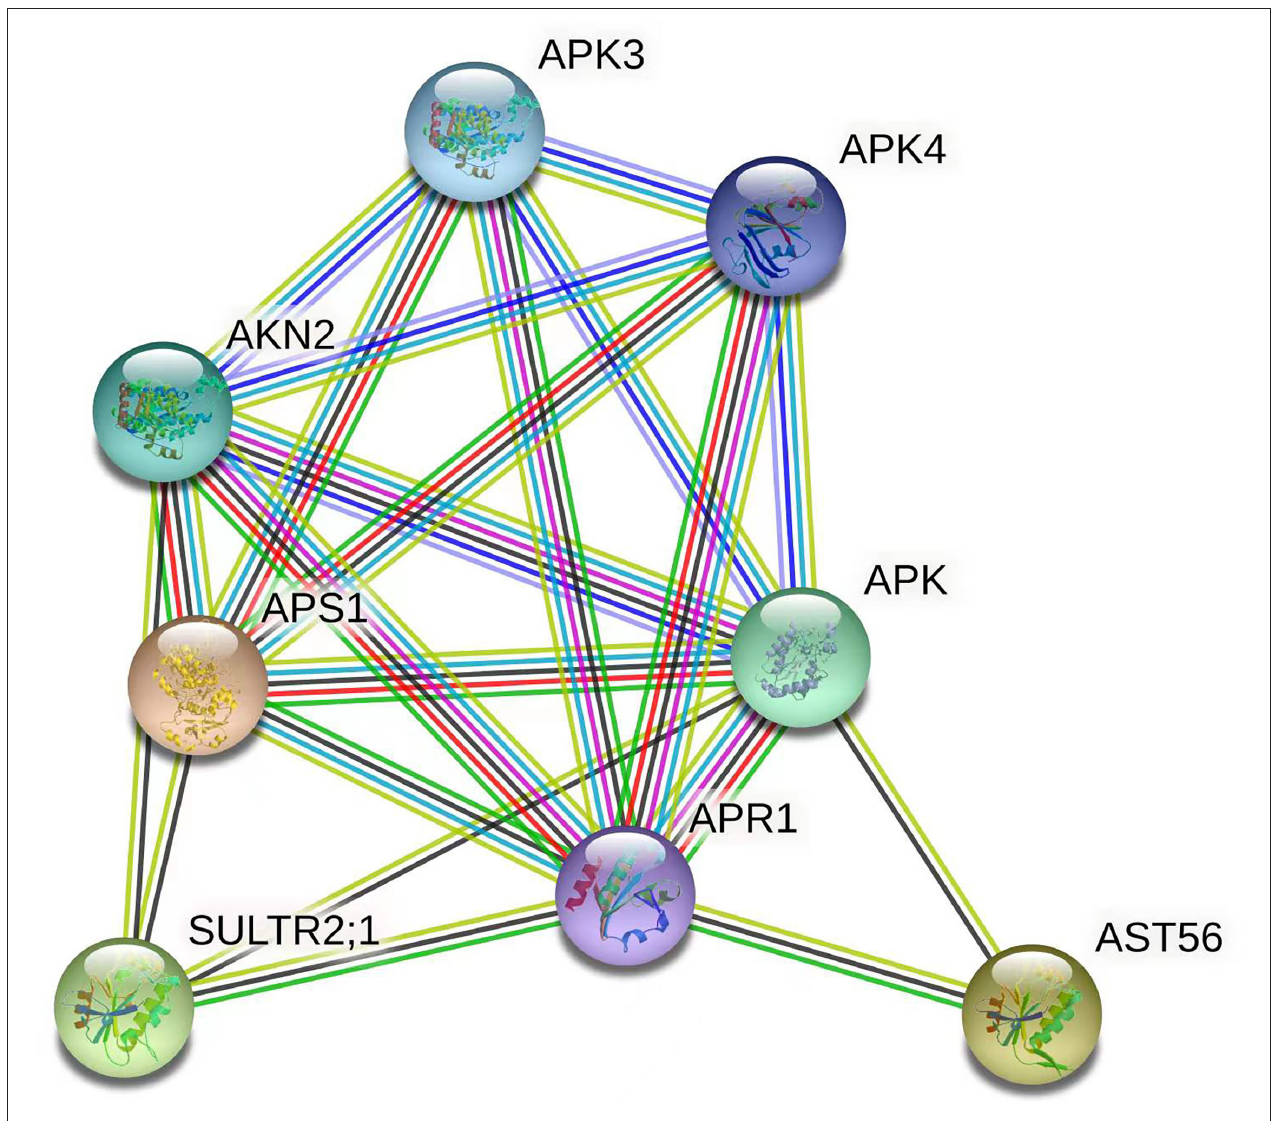
FIGURE 6 | Interaction network of the target genes of Csa-miR395a/b/c. Network nodes represent proteins. Edges represent protein-protein associations. The 3D protein structure was displayed inside the